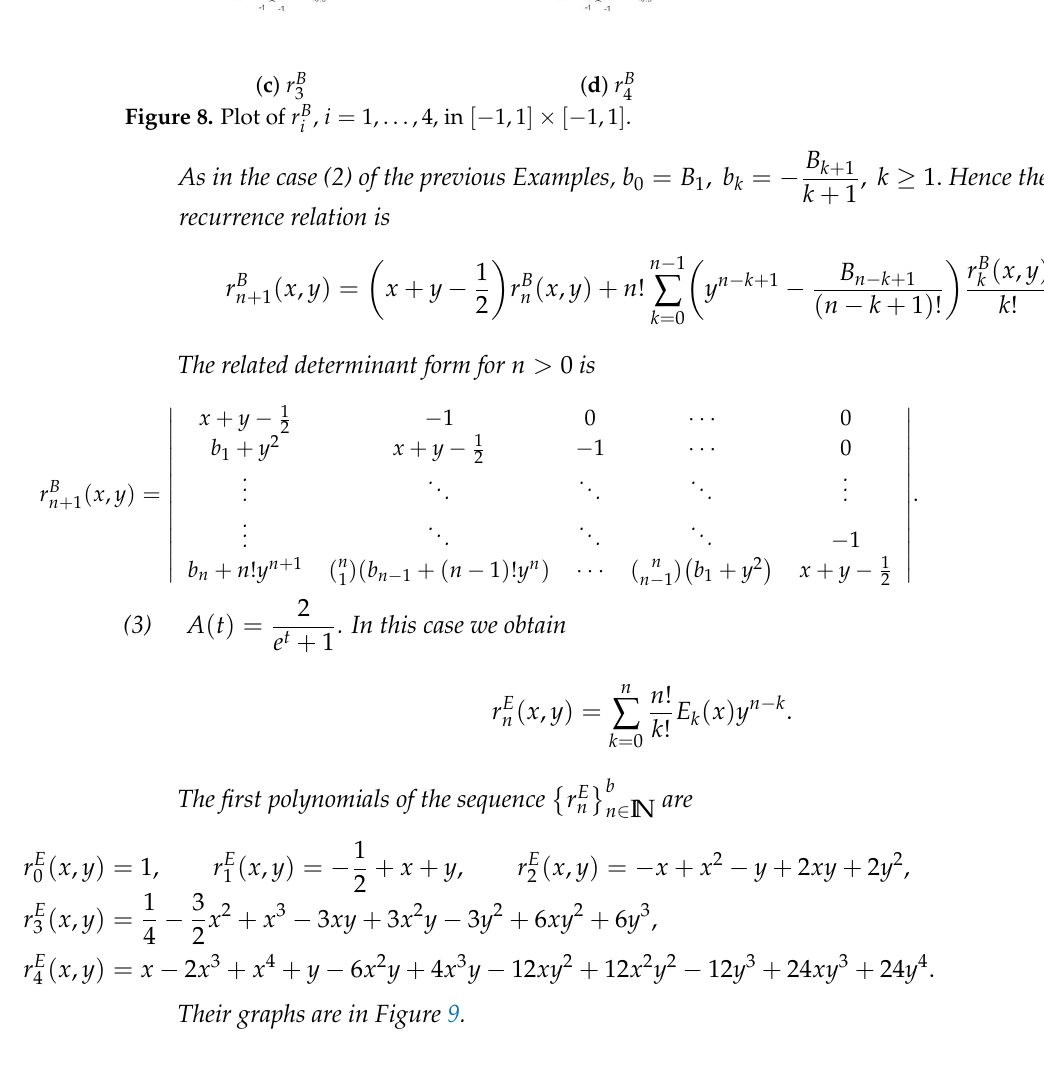
Figure 8. Plot of r B